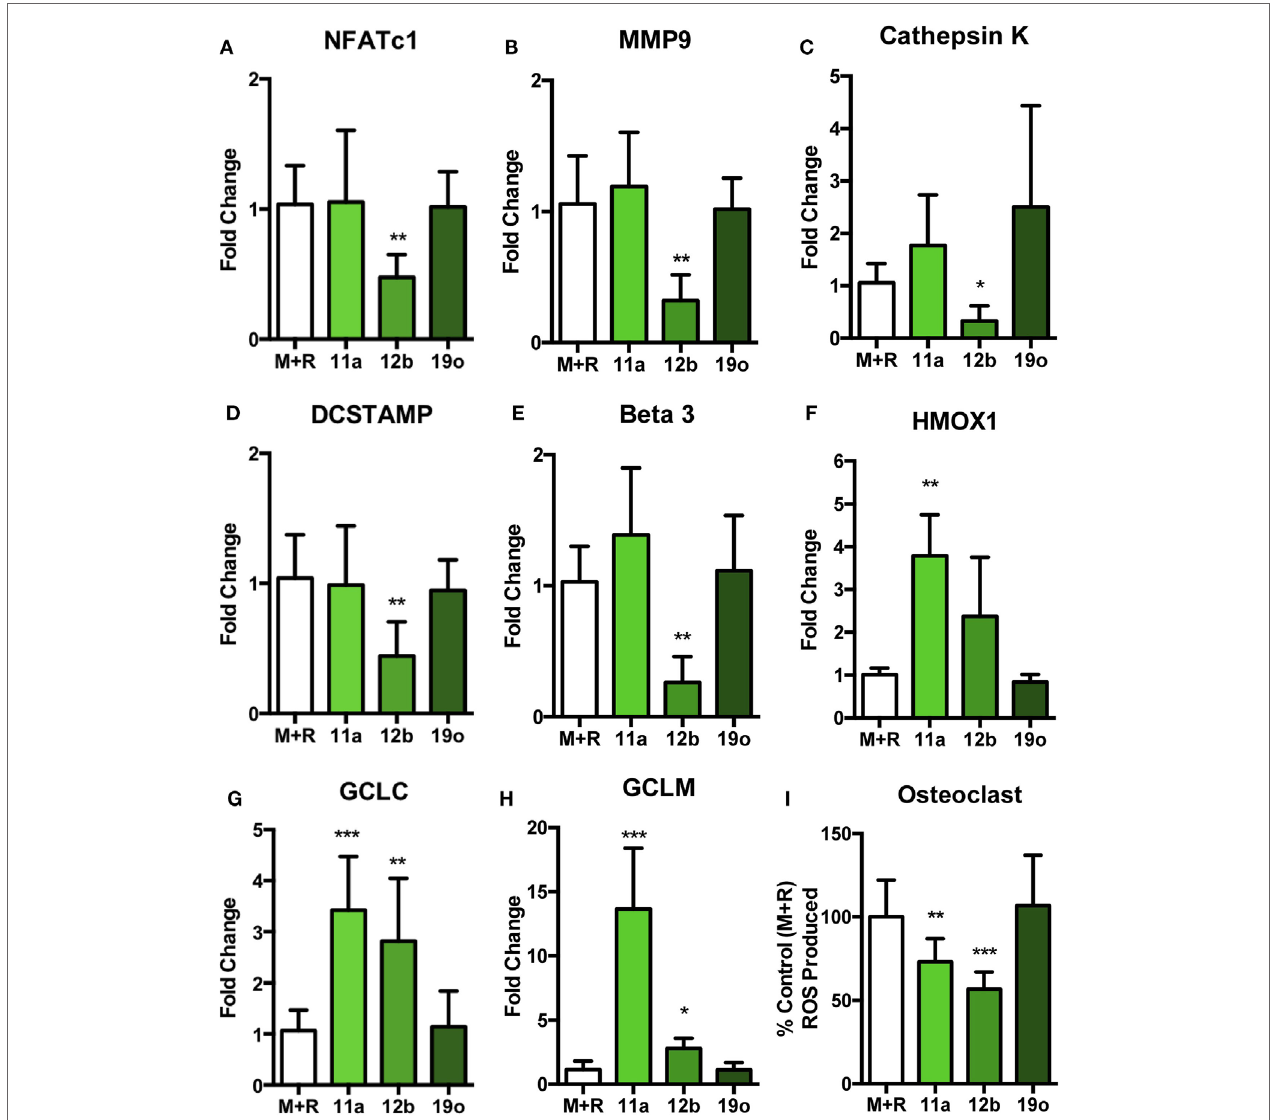
FigUre 5 | SMA 12b downregulates OC-specific gene transcription and induces an antioxidant response during OC differentiation in vitro . Non-adherent BM, from C57BL/6 mice, was harvested and cultured for 4 days with 30 ng/ml M-CSF and 50 ng/ml RANKL (M + R), at which point medium was refreshed and cells were incubated in medium or medium containing 5 µg/ml of SMAs 11a, 12b, or 19o. At day 5 of culture, OCs were lysed, mRNA extracted, and cDNA synthesized. Expression of nfatc1 (a) , mmp9 (B) , ctsk (c) , dc-stamp (D) , itgb3 (e) , hmox-1 (F) , gclc (g) , and gclm (h) mRNA was determined by qRT-PCR to assess the phenotypic profile of OCs. Likewise, on day 5 of culture, following the 24-h treatment with SMAs, OCs (i) were stained using the fluorescent stain DCF-DA to measure the presence of reactive oxygen species (ROS). Data are collated from three experiments performed in triplicate, normalized to the M + R control and presented as mean ± SD. One-way ANOVA with Dunn’s post-test was used to analyze experimental conditions compared to M + R, where * p < 0.05, ** p < 0.01, and *** p <